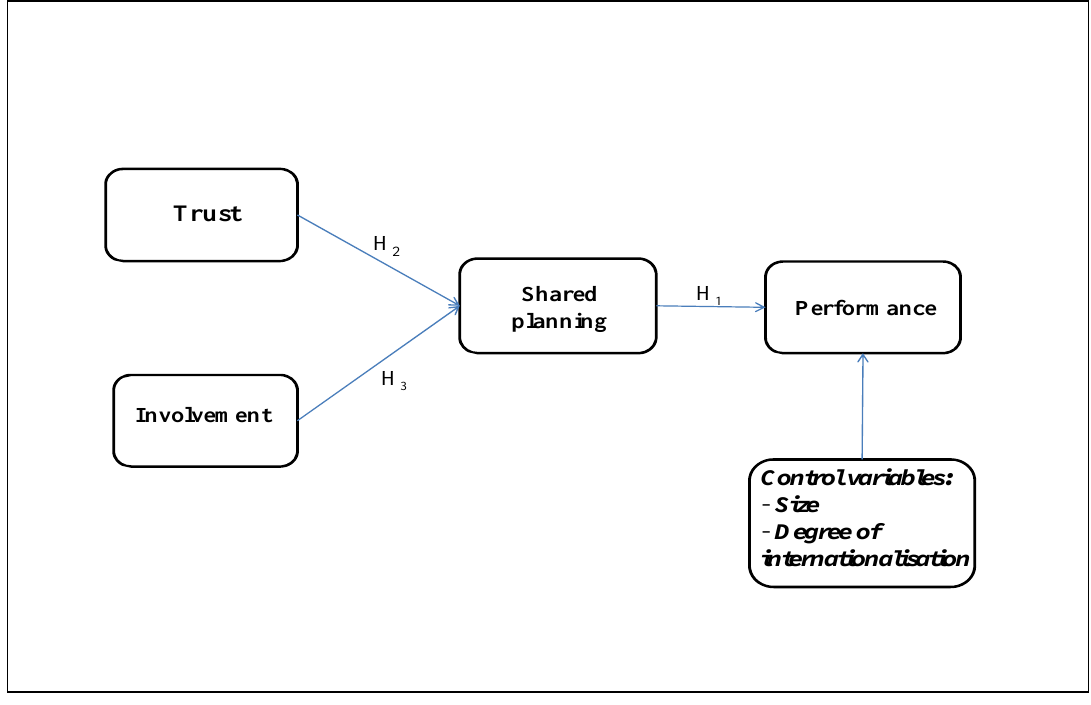
Figure 1. Research